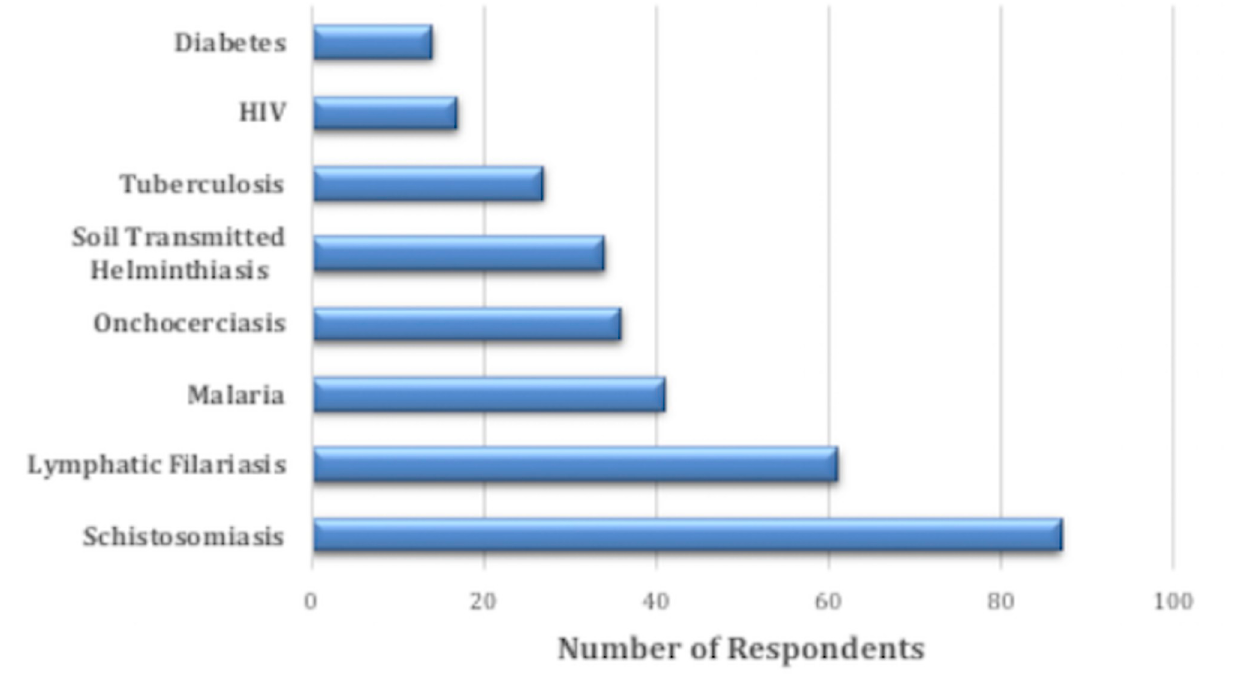
Fig 3. Perceptions of attendees on what NTDs